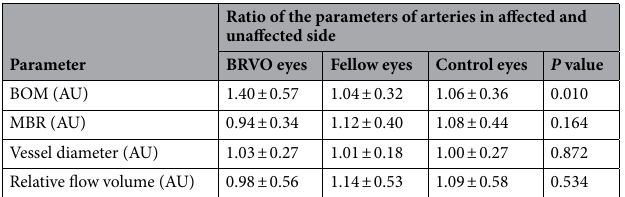
Table 3. Ratio of the parameters of arteries in affected and unaffected side.